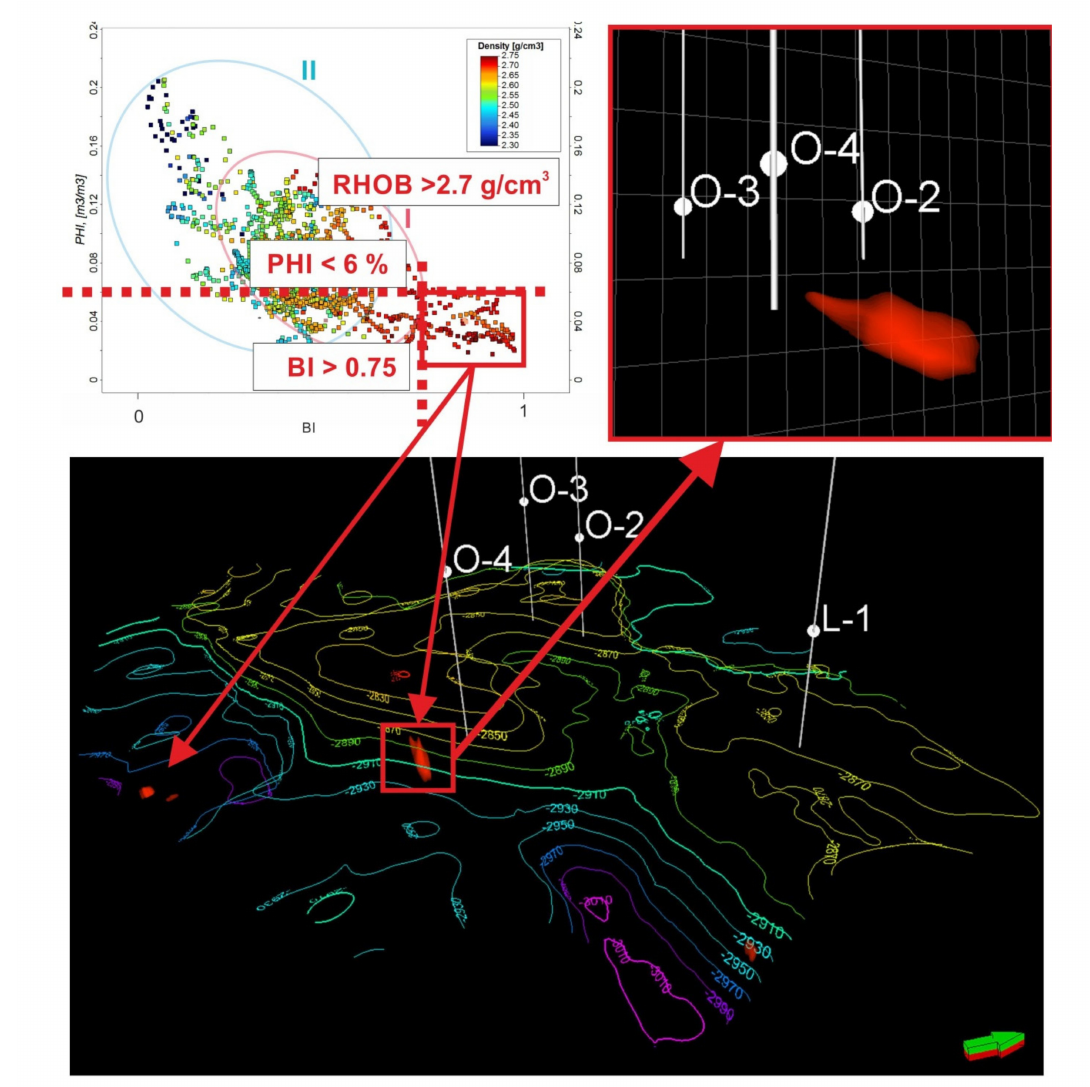
Figure12. Anexampleofapplicationofobservationfromcrossplotpresentingbrittlespotscharacterized by porosity values below 6% and density above 2.7 g / cm 3